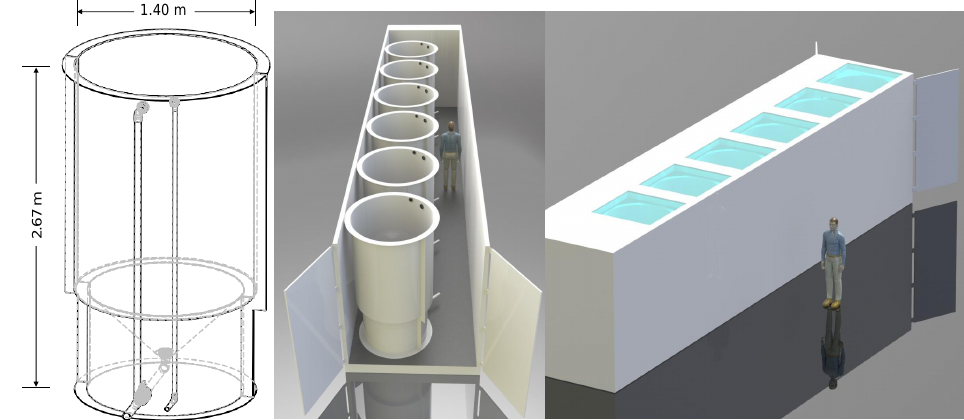
Figure 1. Schematic drawing including mesocosm dimensions and placement within the containers (Aquabiotech Inc., Québec, Canada). The whole setup includes a second container holding six more mesocosms not depicted